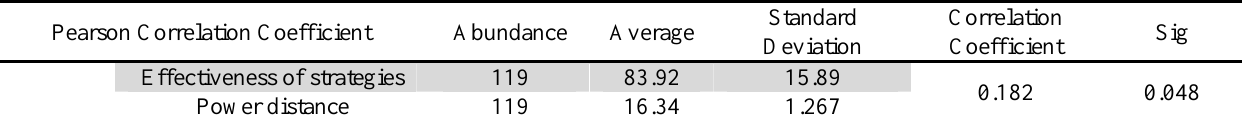
Standard Deviation